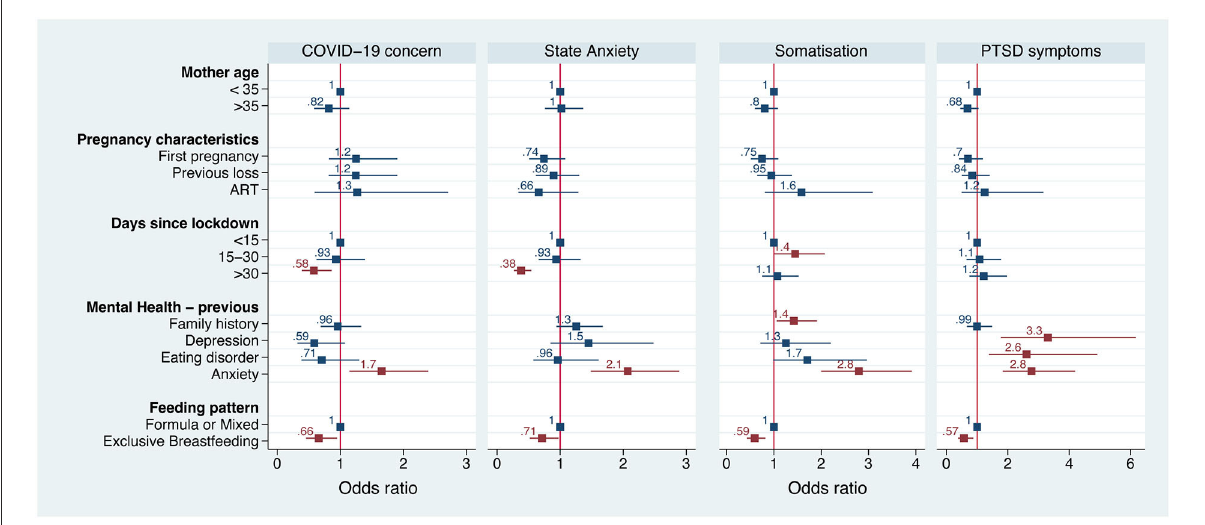
FIGURE4 Forest plot of the logistic regression of several psychopathological parameters according to the most theoretically and statistically significant variables. Numbers and squares represent odds ratios, horizontal line represents 95% CI, red color p < 0.05.